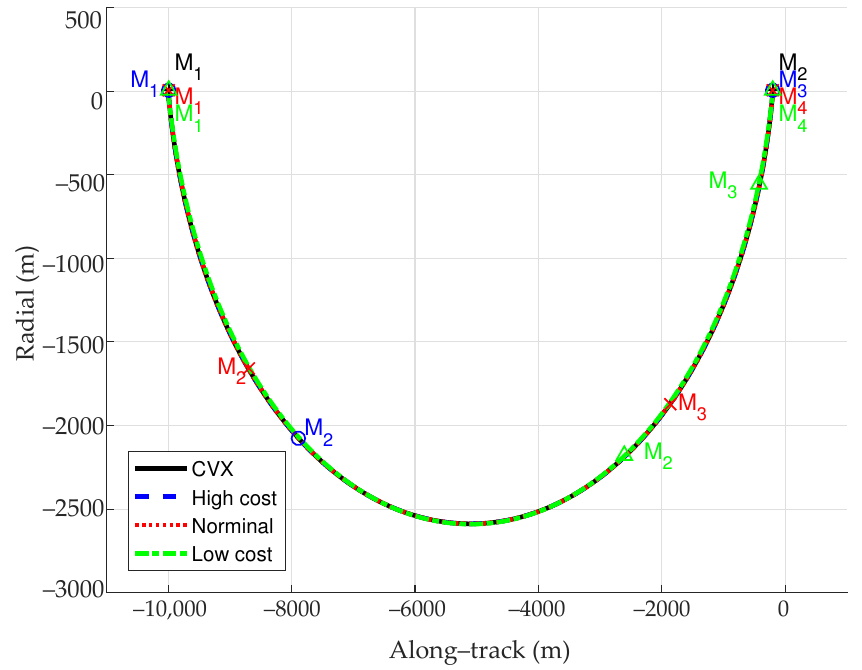
Figure 2. Optimal trajectories (in-plane) when t f = 2000 s.